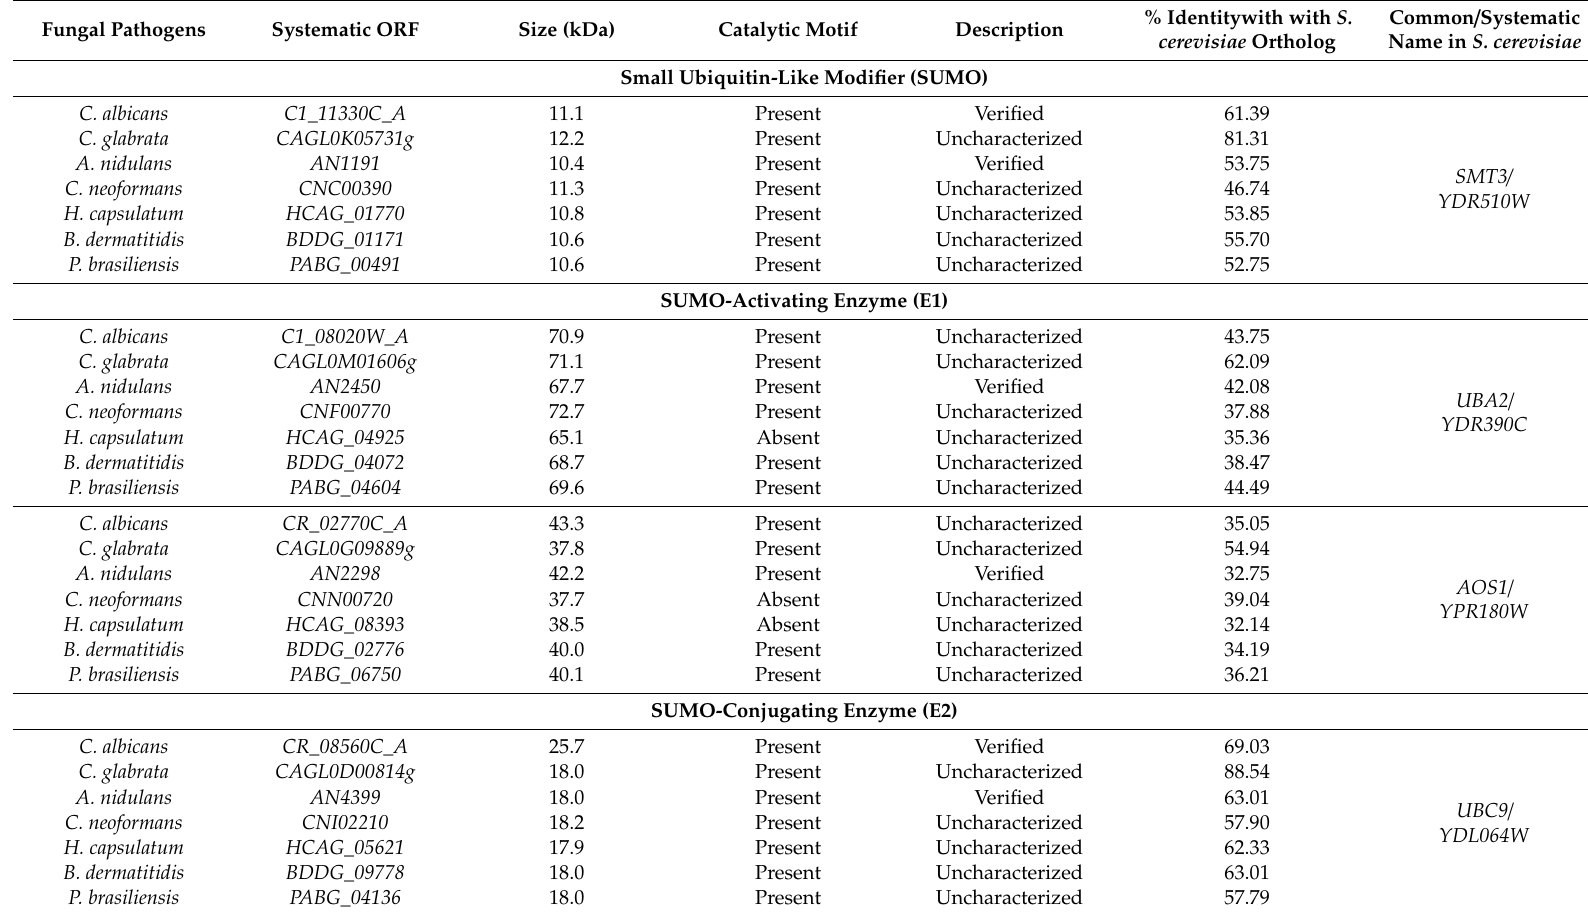
Table 2. A list of SUMOylation components in seven fungi #